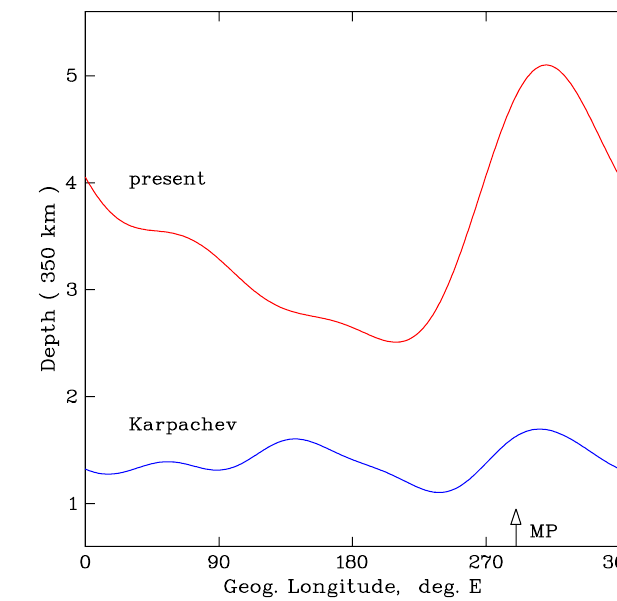
Fig. 15. Comparison of the longitudinal variation in the trough po- sition as derived by Karpachev and Afonin (K&A, 1999) and the present author. Plotted are deviations from the mean, with the mag- netic activity and local time changes removed. The solid blue curve refers to the night sector (18:00 to 06:00 MLT), the green line to the day sector (06:00 to 18:00 MLT) of the K&A study. Our results for latm are indicated by the red curve. The approximate position of the magnetic north pole is indicated by an arrow.